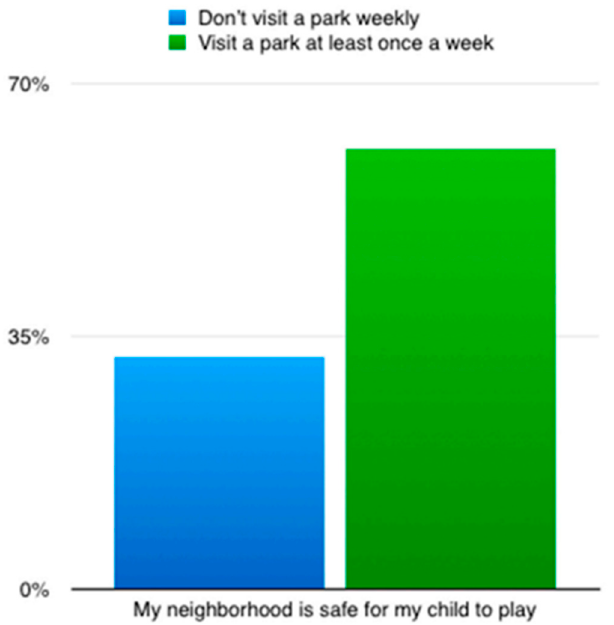
Figure 3. Bar graph showing perceived neighbourhood safety in Razani et al., (2020)’s [68] study. Xaio et al., (2017)’s [86] study evidenced that the differences between park visits for Hispanics and Whites were significant for perceived comfort and safety ( η = 0.11). Addi- tionally, potential improvements in comfort and safety had a positive effect on Black re- spondents’ preference for visitation (OR = 3.24). Evidence also highlighted an increase in park use after installing signalized crosswalks nearby (including for Black participants), suggesting the importance of safe access, to and from parks [85]. 3.3.4. Experience/Knowledge Prior Knowledge about Parks and Locations Increased knowledge about park location was predictive of increased park use, in Razani et al., (2020)’s [68] study. They found that as parents’ park knowledge increased, their visits to parks increased by one park visit over three weeks [(95% CI 0.05, 0.50), p = 0.016]. The authors acknowledged this was a small increase but predicted that this could promote a clinically significant increase over several months. Nature Affinity Razani et al., (2020) [68]reported low nature affinity as a barrier, whilst accounting for seasonal effects (by assessing during both the summer and winter months) they found evidence for a positive association between nature affinity and improved park vis- its. As nature affinity increased (assessed via a seven-point scale) park visits increased by one visit every three weeks.